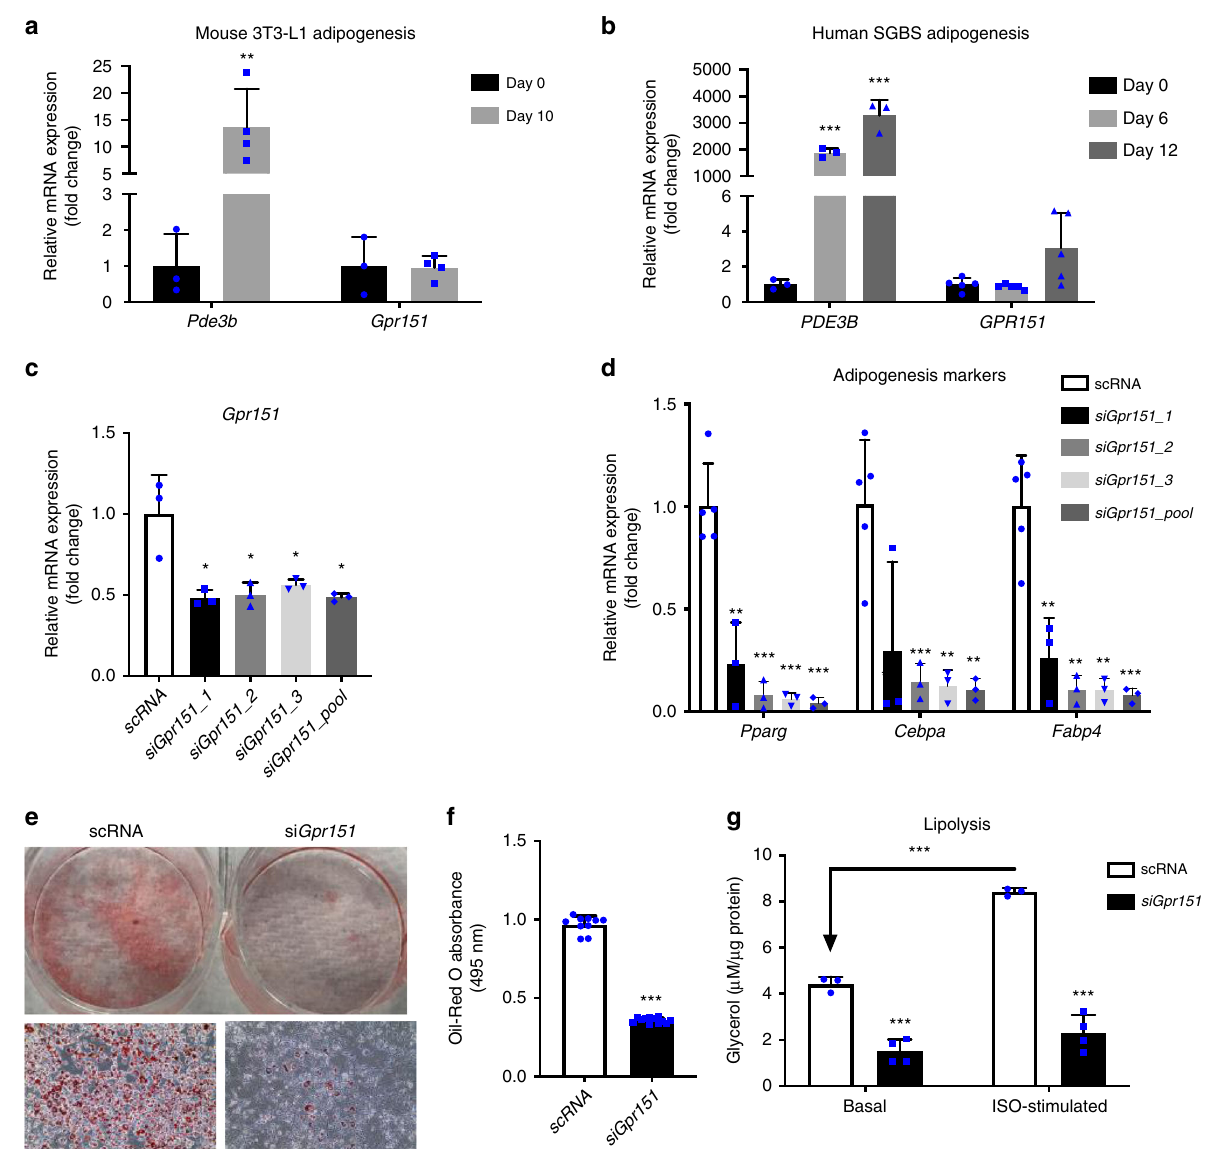
Fig. 5 Experimental validation of GPR151 and PDE3B function in adipogenesis. a , b qPCR analysis of gene expression patterns of PDE3B and GPR151 during ( a ) mouse 3T3-L1 adipogenesis and ( b ) human SGBS adipogenesis. For 3T3-L1 cells, n = 3 independent samples for day 0, n = 4 for day 10. For SGBS cells, n = 3 independent samples for all timepoints of PDE3B analysis, n = 5 for all timepoints of GPR151 analysis. c qPCR analysis of Gpr151 mRNA knockdown in 3T3-L1 preadipocytes, by 3 siRNAs targeting Gpr151 individually and together. n = 3 independent experiments. d qPCR analysis of the effect of si Gpr151 knockdown (individually and together) on adipogenesis markers, Pparg , Cebpa and Fabp4 . n = 3 independent experiments. e – g Oil-Red O staining ( e ), quanti fi cation of lipid droplets ( f ), and lipolysis ( g ) in scRNA- or si Gpr151 -tansfected adipocytes. ×10 magni fi cation. Scale bar = 100 μ m. For ORO imaging and quanti fi cation, n = 10 independent cell cultures for scRNA, n = 12 for si Gpr151 . For lipolysis, n = 3 independent experiments. Means ± SEM are shown (*** p -value < 0.001, ** p -value < 0.01, * p -value < 0.05). scRNA: scrambled siRNA. ISO: isoproterenol. Source data are provided as a Source Data fi